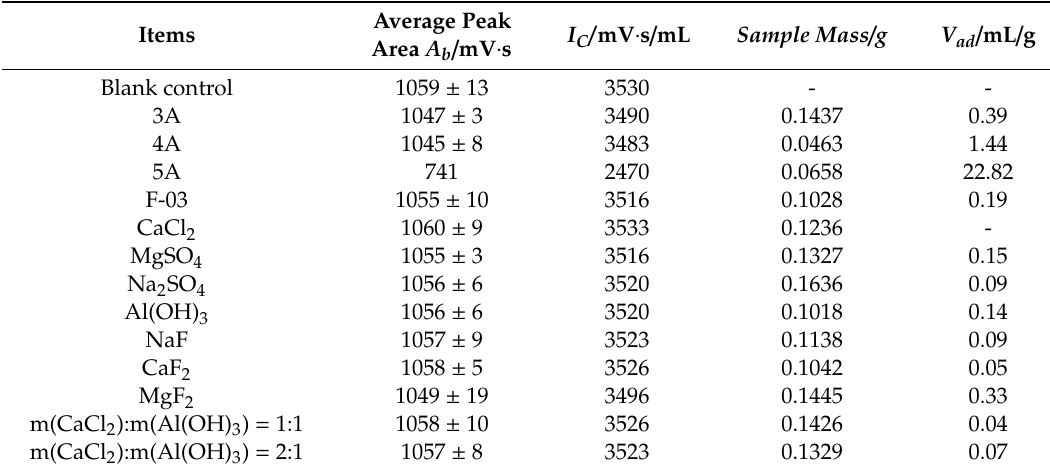
Table 2. Adsorption performance of the materials with C 4 F 7 N based on the integrated area of pulse